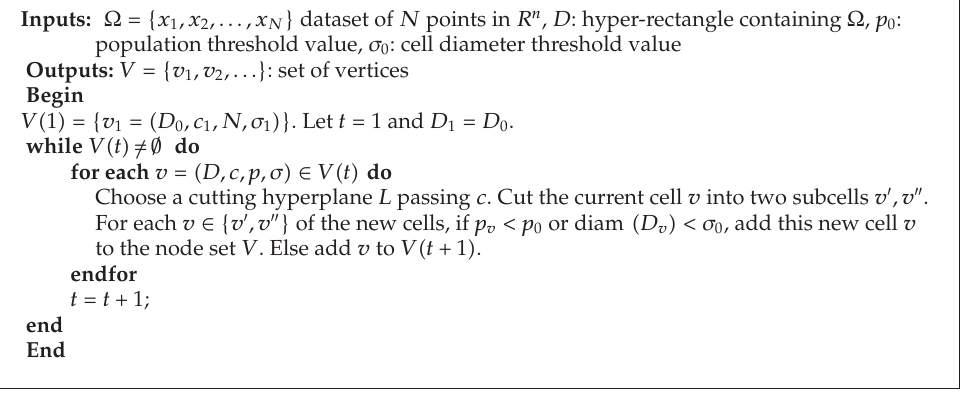
Algorithm 1: A flexible grid construction